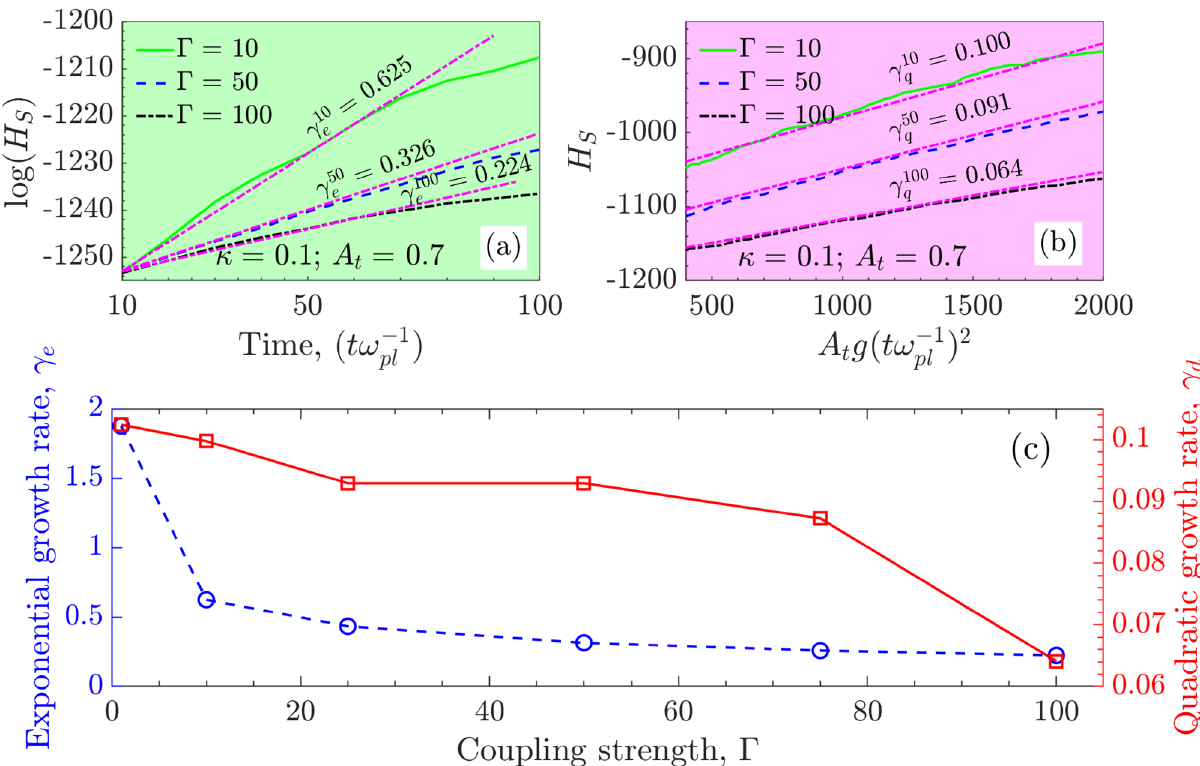
Figure 5. Effect of coupling strength Ŵ on the growth rate of single-mode RTI. ( a ) Growth rate in exponential regime γ e and ( b ) growth rate in quadratic regime γ q . Both show the same trend in the growth rate i.e., the decrease in growth with an increase in Coulomb coupling strength. ( c ) The exponential γ e and quadratic γ q growth rate dependence on coupling strength Ŵ